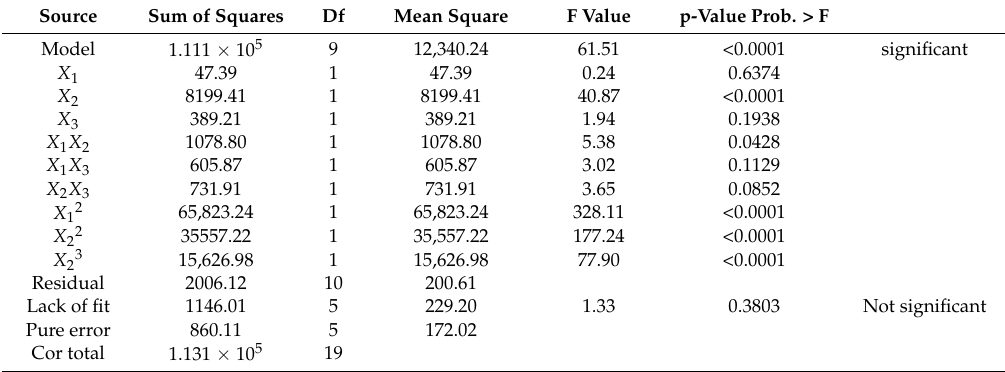
Table 3. ANOVA of the regression model for the response variables (size) and independent variables ( X 1 , X 2 , X 3